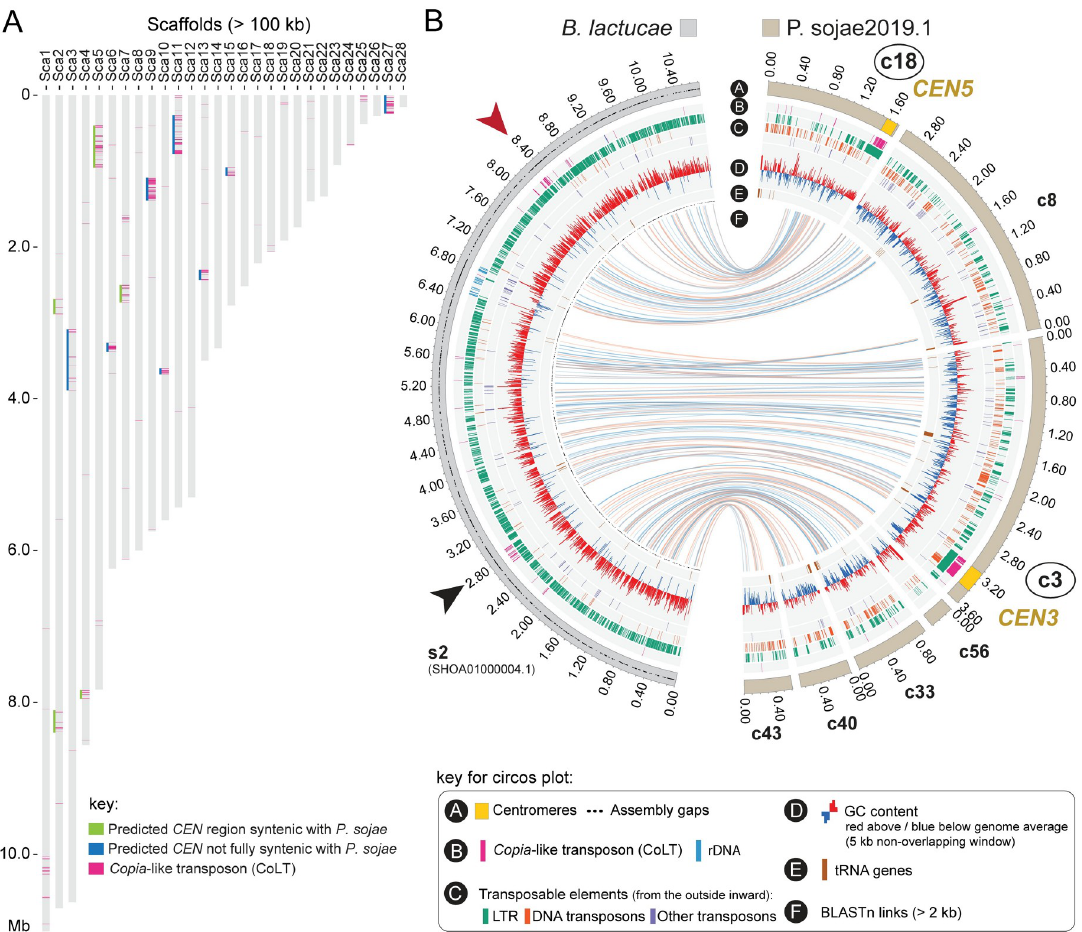
Fig 7. Genomic distribution of CoLT in the Bremia lactucae genome. (A) Location of CoLT elements across all B . lactucae scaffolds > 100 kb. For ease of analysis, scaffolds in the B . lactucae assembly were sorted and re-named based on sizes (large to small). See S5 File for the original scaffold names. Regions underlined by green lines indicate that both sides of the CoLT clusters are syntenic with the regions surrounding the P . sojae centromeres. Regions underlined by blue indicate only one side of the CoLT clusters was found to be syntenic with P . sojae centromere flanking sequences. (B) A representative Circos plot comparing a B . lactucae scaffold that has clustered CoLT elements (Scaffold 2)with the corresponding Psojae2019.1 contigs. The outer track illustrates the assembled scaffold (in the sorted B . lactucae assembly) or contigs (in Psojae2019.1), which is color coded as shown at the top. Names of contigs possessing P . sojae centromeres are enclosed in circles. Yellow regions on the outer tracks indicate the locations of centromeres (CENP-A binding regions). Blue and orange lines in track F link regions with synteny extending over 2 kb, with orange lines corresponding to inversions. Two CoLT clusters are identified in the B . lactucae Scaffold 2 (s2; original scaffold, SHOA01000004.1), which are indicated by arrowheads of different